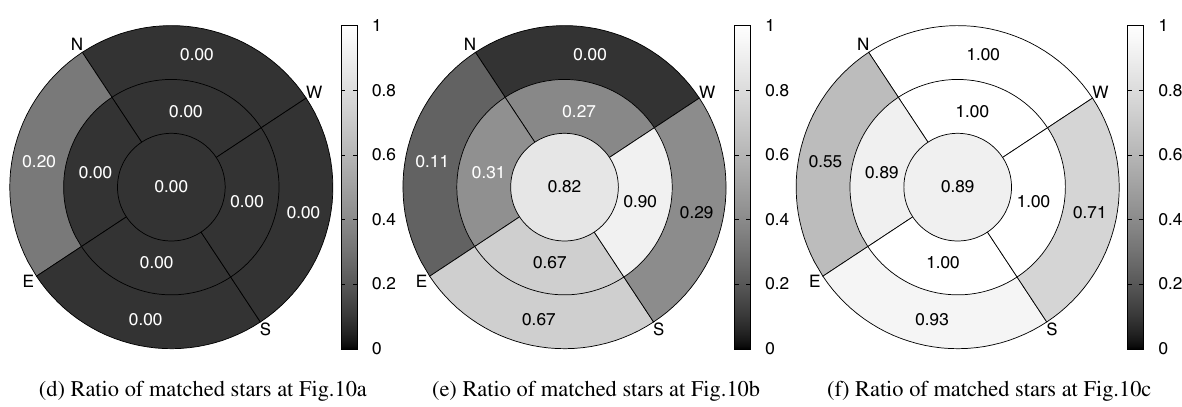
(a) Picture of 1 ⃝ in Fig. 9(03:38(UTC)). Matched stars : 2 , Expected stars : 97.